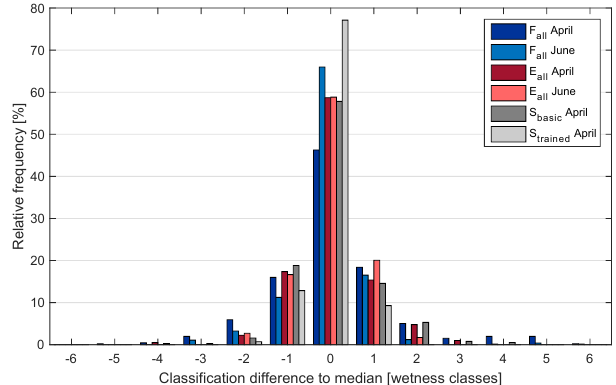
Figure 4. Deviation of wetness class assignments relative to the median of all farmers ( F all ), and all experts ( E all ) during the test in April and June and of all students with a basic introduction ( S basic ) and students with training ( S trained ) during the test in April.